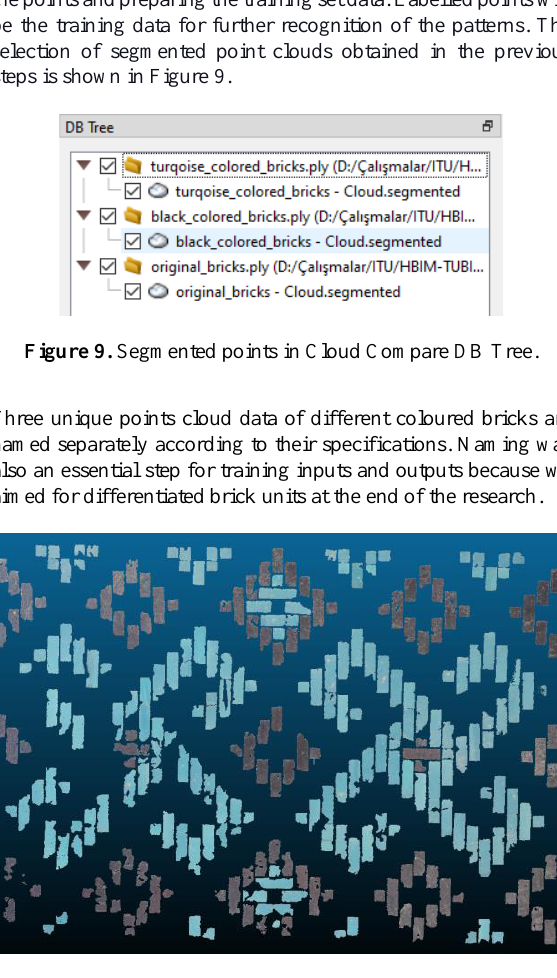
Figure 10. A screen shot of Cloud Compare 3D view